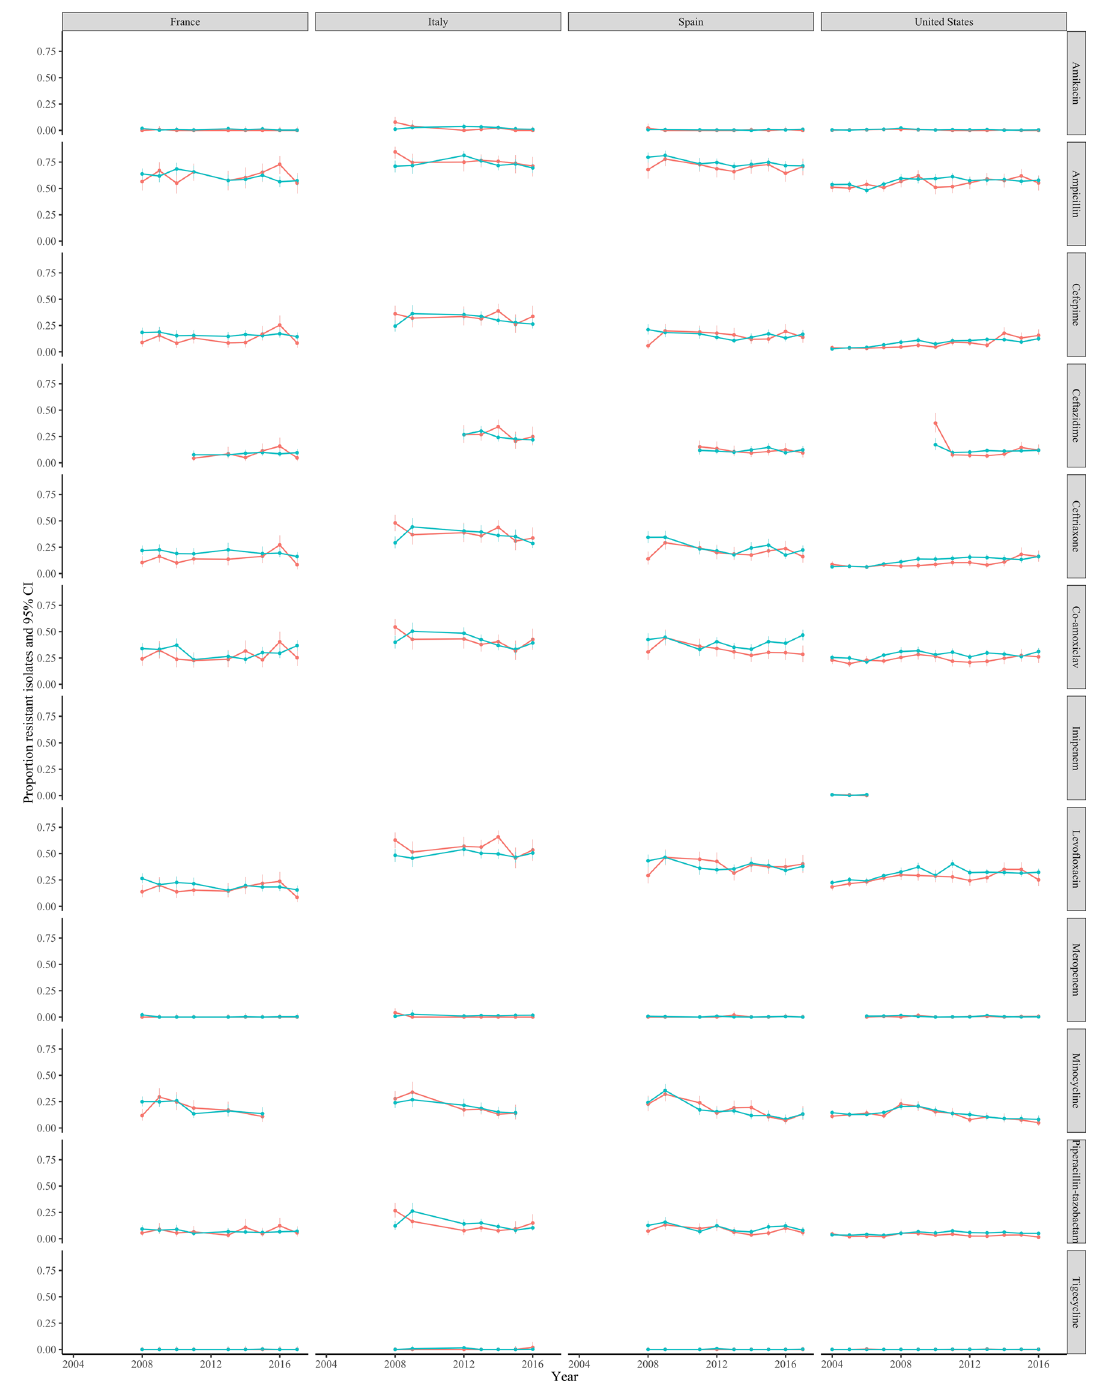
Figure 3. Resistance prevalence in E. coli in blood versus non-blood cultures in high-income countries present in the ATLAS dataset,